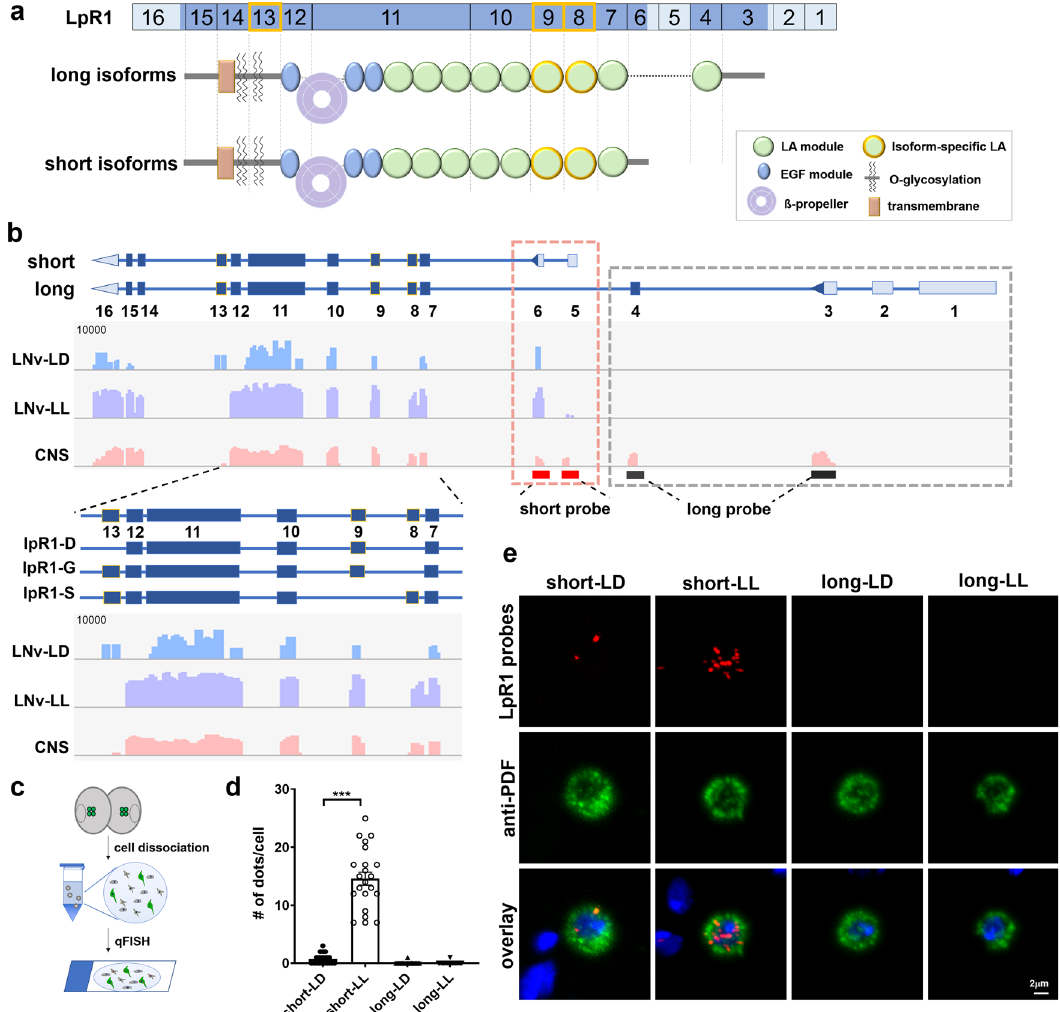
Fig. 1 Isoform-speci fi c expression of LpR1 is detected in the LNvs. a A schematic illustration of long and short isoforms of the LpR1 receptor. Top: exon organization of the LpR1 gene. Untranslated regions are in light blue, coding exons are in dark blue. Flexible exons are outlined with orange borders. Bottom: protein domains of LpR1. Long and short-isoforms differ in their N-terminal regions (gray bars) and the numbers of LA modules (green circles). b Exon- mapping of RNA-seq data reveals that only LpR1-short isoforms are expressed in LNvs in both light: dark (LD) and constant light (LL) conditions. Top: schematic representation of the LpR1 gene structure. Bottom: Reads from LNv-speci fi c and CNS RNA-seq libraries mapped to each exon of the LpR1 gene. The lower panel shows a magni fi ed view of the fl exible exons and the corresponding LpR1-short isoforms. Untranslated regions are in light blue, coding exons are in dark blue, and fl exible exons are outlined with orange borders. Reads number is log scaled. Top Right: isoform-speci fi c FISH probes targeting LpR1-short (red bars) and LpR1-long (black bars) speci fi c sequences. c A diagram illustrating the work fl ow for qFISH with dissociated brain cells. d Only LpR1- short is expressed in LNvs and is upregulated by excessive visual input in the LL condition. Quanti fi cations of the transcript levels (# dots/cell by qFISH) of LpR1-short and LpR1-long in LNvs from LD and LL conditions are shown. Data are presented as mean values + / − SEM. Statistical signi fi cance was assessed by one-way ANOVA with Tukey ’ s post hoc test. ANOVA: p < 0.0001, F = 143.3, df = 78; short-LD/short-LL: p < 0.0001; long-LD/long-LL: p > 0.9999. n = 20, 22, 20, and 20 for short-LD, short-LL, long-LD, and long-LL, respectively. n represents individual LNvs. *** p < 0.001. e Representative confocal images of qFISH results on single LNvs are shown (observed in at least 20 individual cells). LpR1-short transcripts (red dots) are detected in LNvs (stained by anti- PDF in green). Nuclei are stained by DAPI